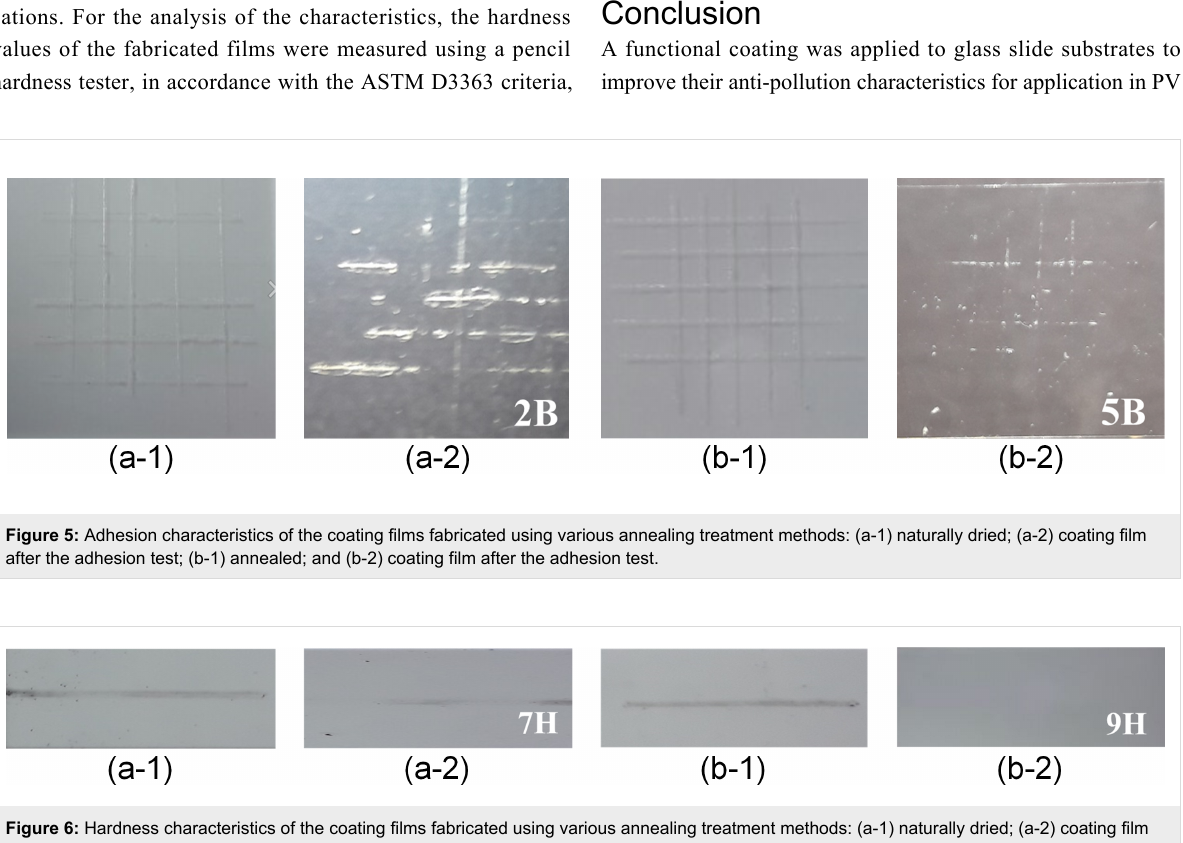
mens thermally annealed using three to five torch applications exhibited the most excellent